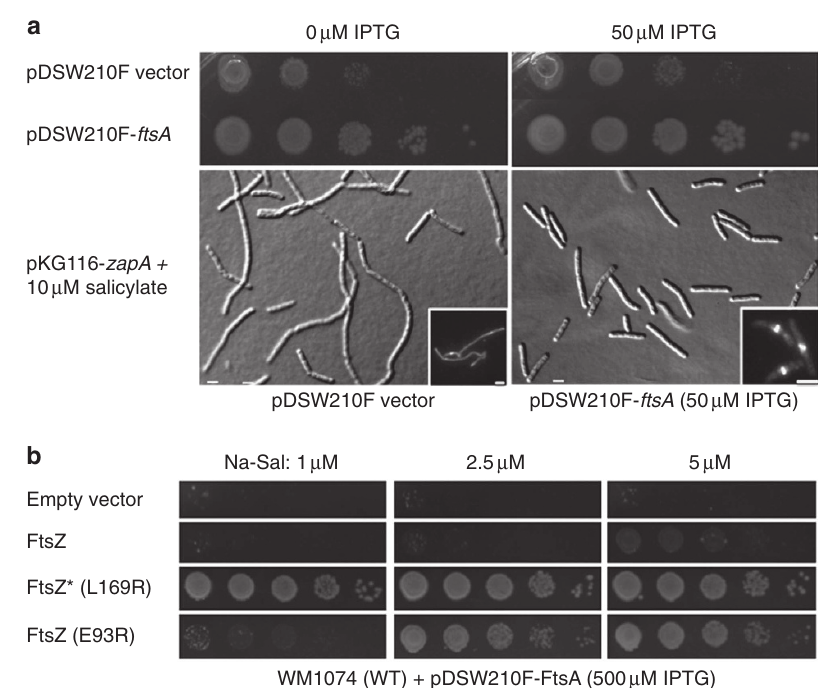
Figure 1 | Suppression of ZapA overproduction toxicity by FtsA. ( a ) WM1074 cells harbouring pKG116-ZapA and either pDSW210F or pDSW210F-FtsA were spot diluted on plates containing 10 m M sodium salicylate and 0 or 50 m M IPTG to induce pKG116 and pDSW210F, respectively. Corresponding differential interference contrast (DIC) images of WM1074 cells co-overproducing ZapA and pDSW210F constructs are shown below. Insets show immunofluorescence microscopy (IFM) of FtsZ. Scale bars, 2 m m. ( b ) WM1074 cells harbouring pDSW210F-FtsA and either pKG110, pKG110-FtsZ, pKG110-FtsZ* or pKG110-FtsZ E93R were spot diluted on plates containing the indicated levels of sodium salicylate and 500 m M IPTG to induce pKG110 derivatives and pDSW210F-FtsA,